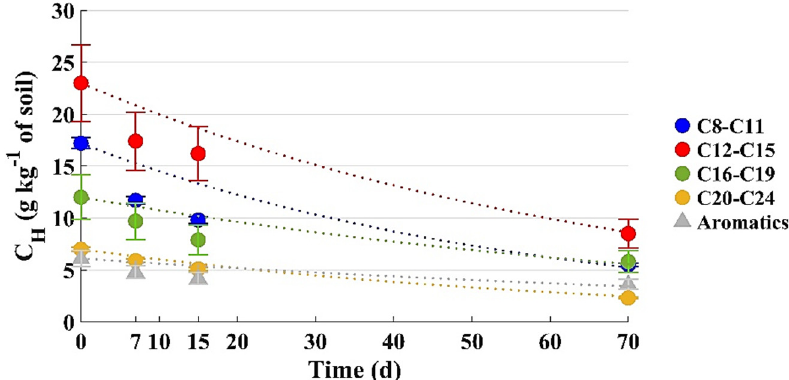
Figure 6. Second-order model. Relative standard deviation range: 2.79–14.95%.